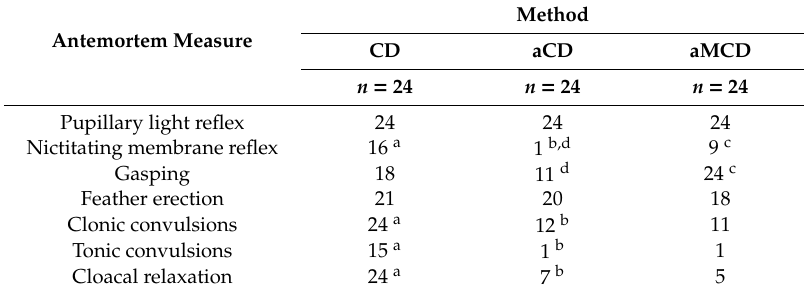
Table 5. Number of birds exhibiting antemortem measures following application of the killing methods.